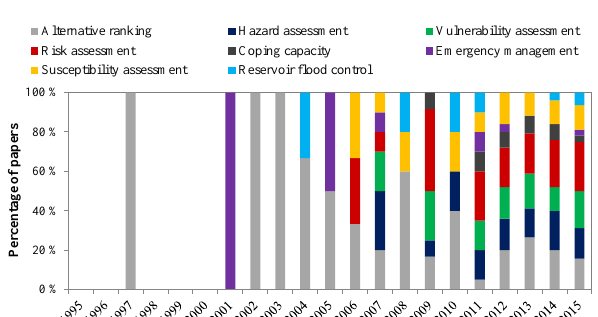
Figure 3. Distribution of MCDM papers by application area be- tween 1995 and June